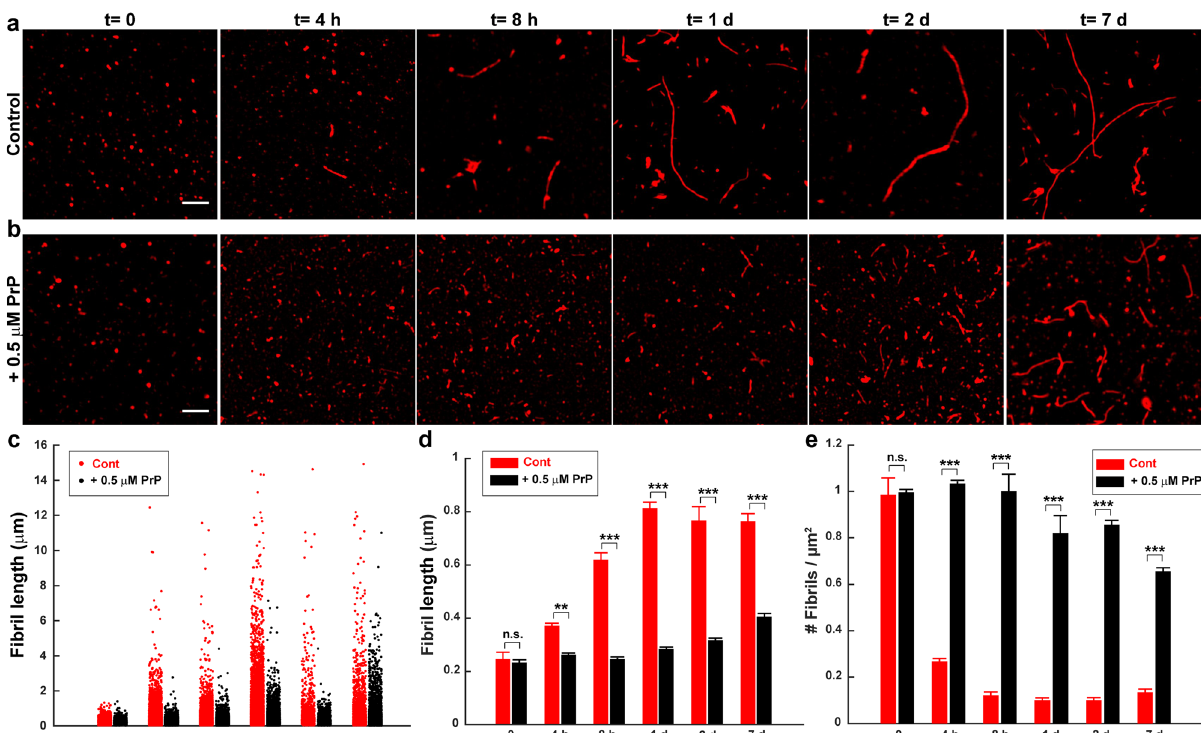
Fig. 2 PrP slows the growth of A β fi brils. A β -Cy5 monomer (20 µ M) was polymerized for the indicated times in the presence of 0 µ M ( a ) or 0.5 µ M ( b ) PrP-AF555. Fibrils were then imaged by SIM. Scale bar in ( a , b ) ( t = 0) is 1 µ m. c Distributions of fi bril lengths at each time point in the presence of 0 µ m (red dots) or 0.5 µ M PrP-AF555 (black dots). Each dot represents an individual fi bril. d , e Bars indicate the mean length of fi brils ( d ) and the number of detectable A β -Cy5 fi brils/ μ m 2 ( e ) at each time point for 0 and 0.5 µ M PrP-AF555. Data represent mean ± S.E. * P < 0.05, ** P < 0.01 and *** P < 0.001 (two- sided Student ’ s t -test). The numbers of biological independent samples ( N ) and analyzed images ( X ) in each conditions are: N ≥ 3, X ≥